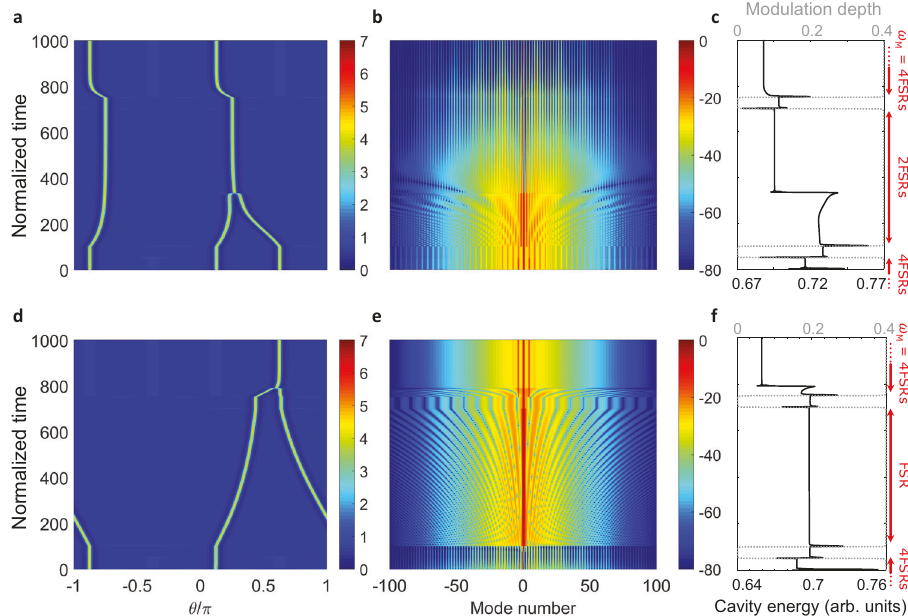
Fig. 6 Controlled switching of discrete time crystal states. Controlled switching between discrete time crystal (DTC) states is possible in a Kerr microresonator driven by a phase-modulated pump through changing the modulation frequency. Two scenarios of switching from a 4-DTC to a 2-DTC ( a – c ), and from a 2-DTC to another 4-DTC ( d – f ) are depicted. Panels a , d illustrate the temporal evolution of the pulse trains while ( b , e ) show their frequency spectra. The intra-cavity energy and modulation depth and frequency are shown in c , f . Pump detuning is fi xed throughout the process.